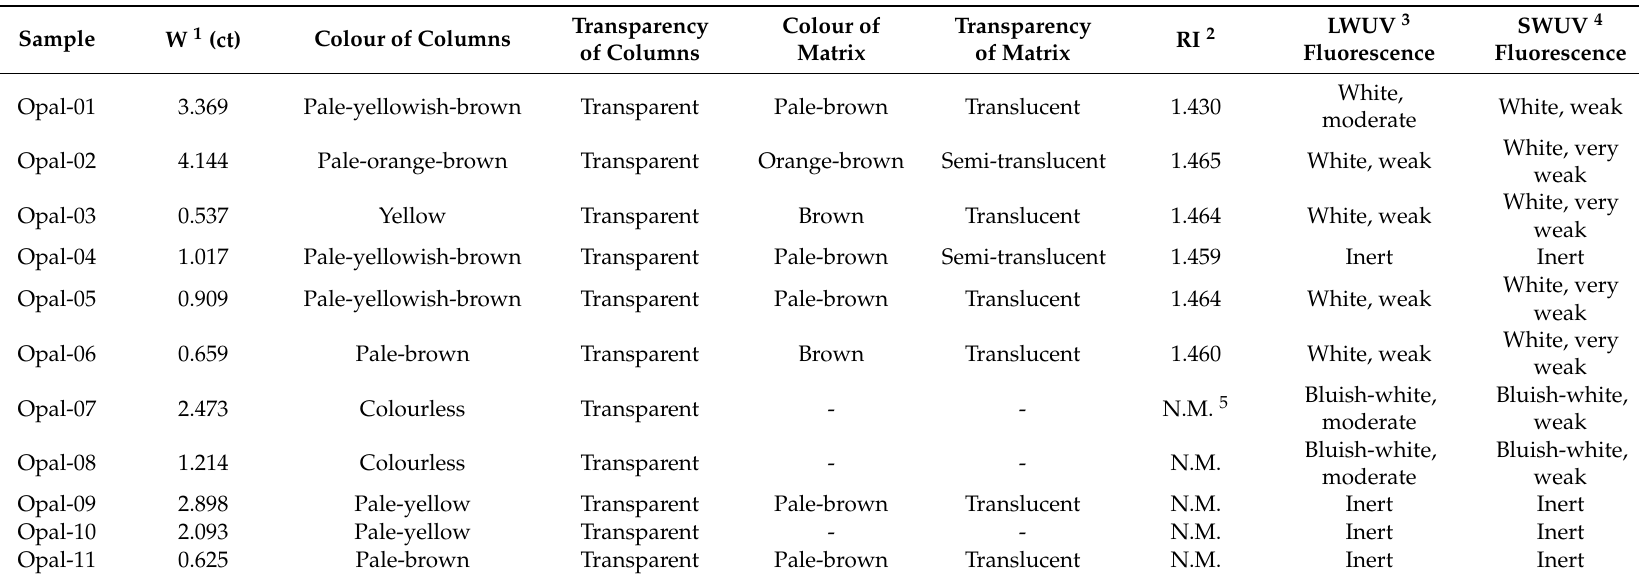
Table 1. Descriptions of appearance and gemmological properties. Opals 07, 08 and 10 do not show a digit pattern. No visible inclusions are observed under the gemmological